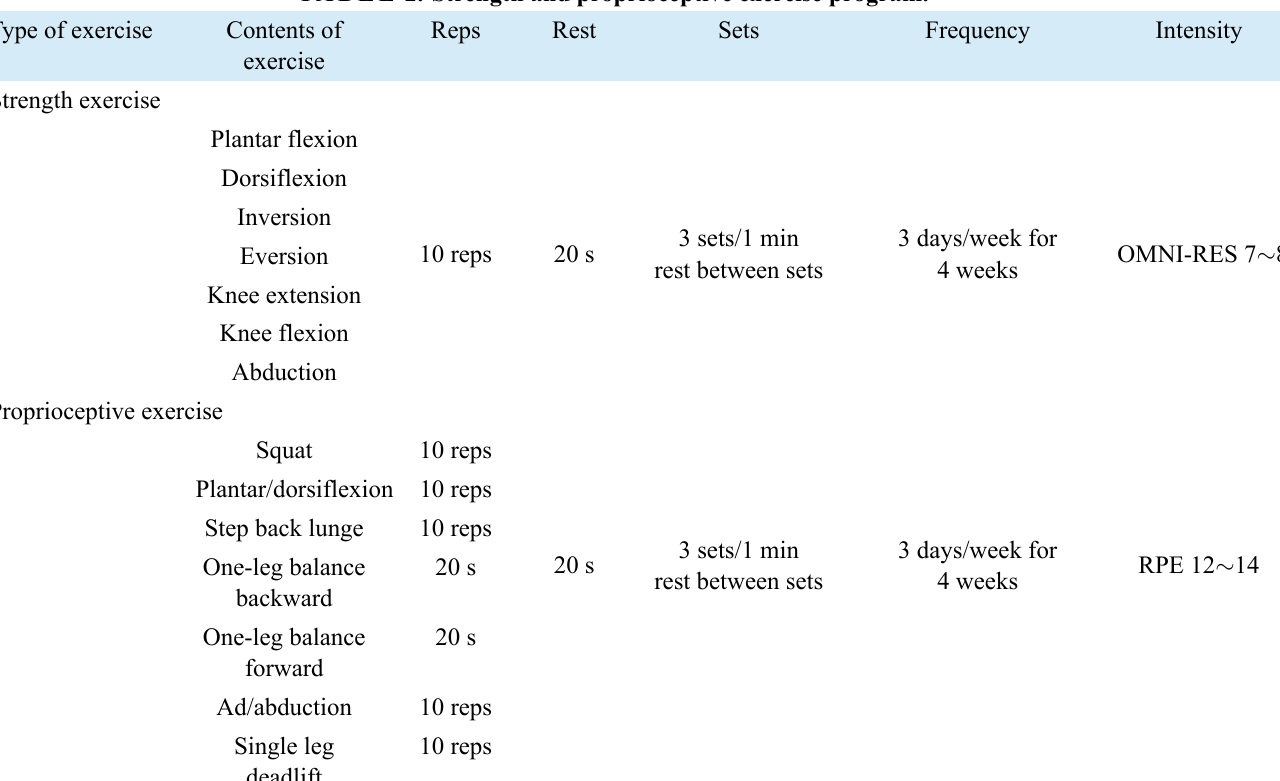
TABLE 2. Strength and proprioceptive exercise